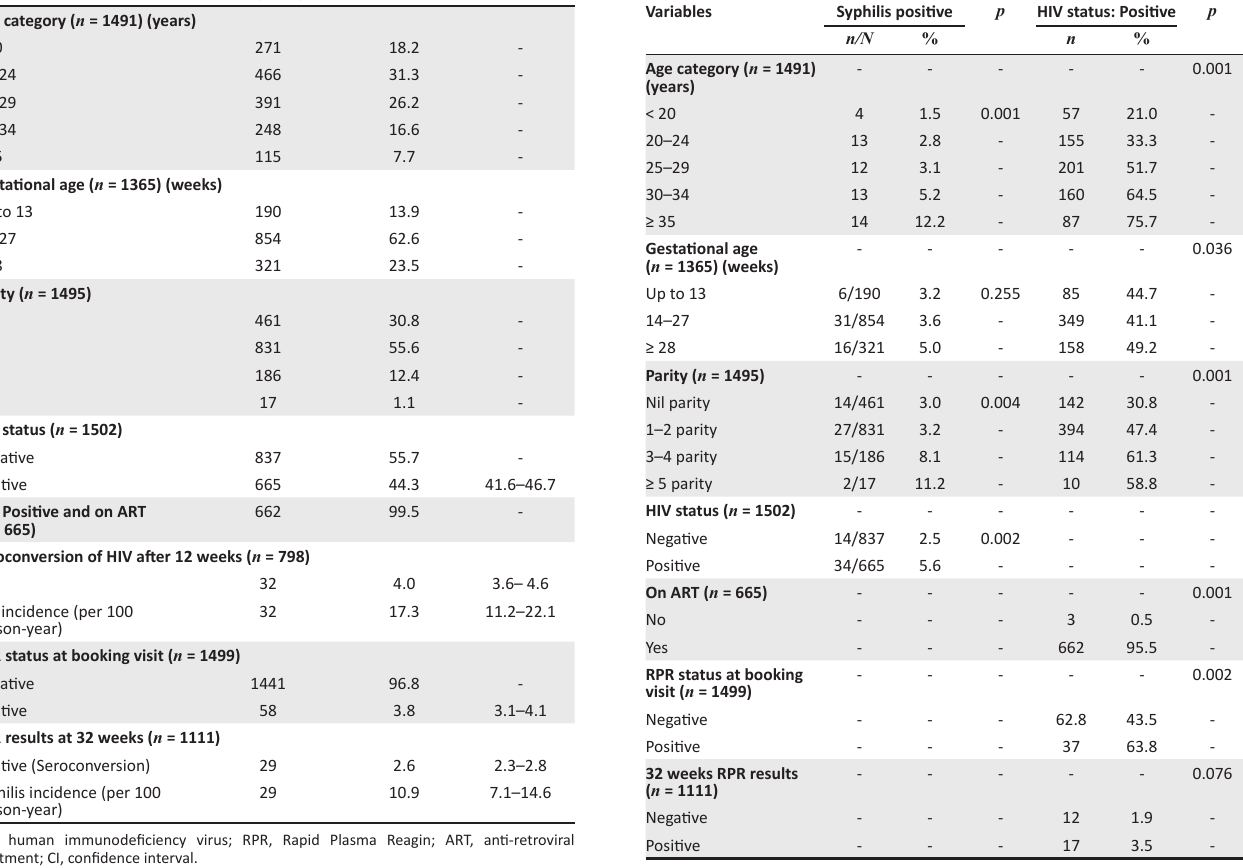
TABLE 1 : Demographic, obstetric and outcome variables of the study sample at booking visit.